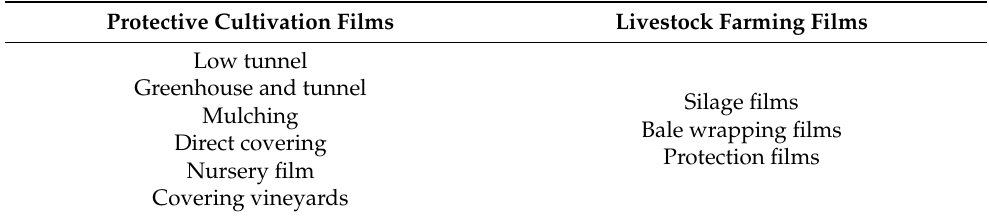
Table 5. Most common applications of plastic films in agriculture. Reprinted with the permission from [87]. (Copyright 2012,